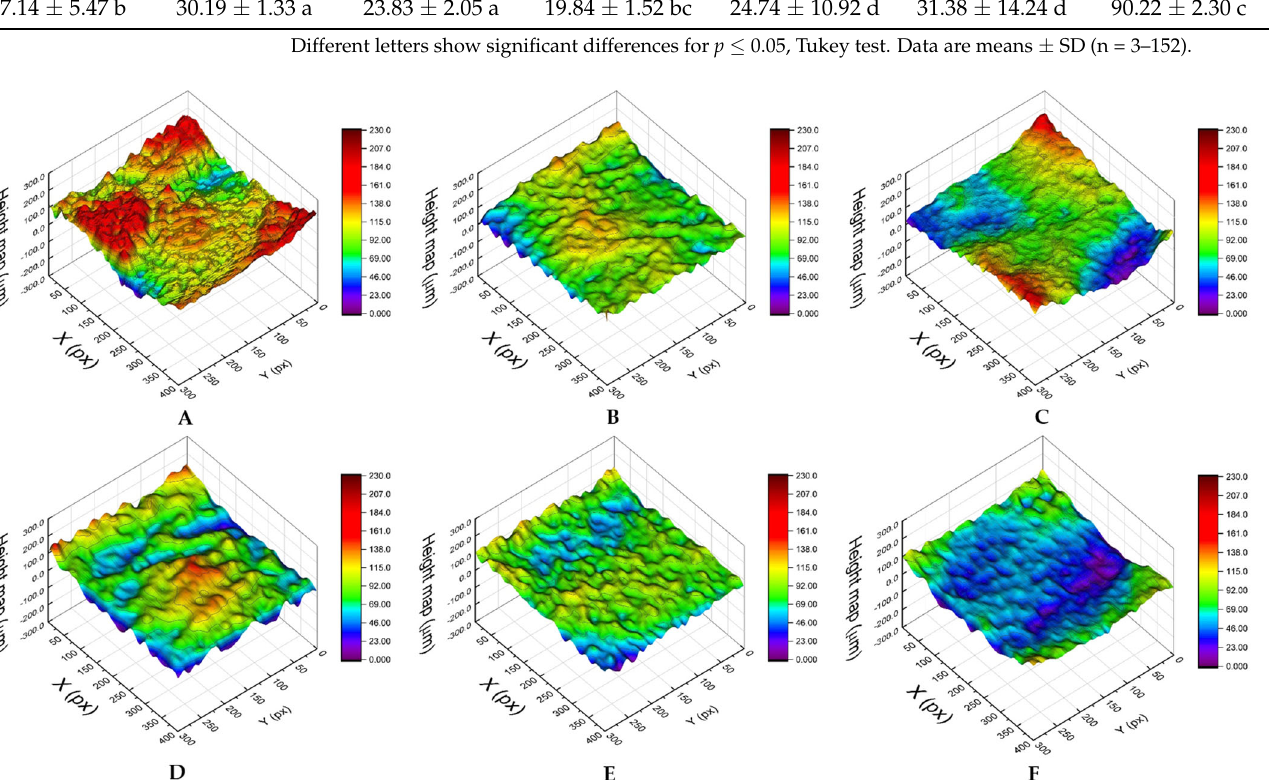
Figure 3. Examples of leaf surface 3D reconstructions of the six selected accessions: romaine lettuce ‘Bionda degli Ortolani’ ( A ), Swiss chard ( B ), rocket ( C ), wild rocket ‘Yeti’ ( D ), wild lettuce ( E ) and lamb’s lettuce ‘Trophy F1 ′ ( F ). X and Y axes are expressed in pixels (1 pixel = 17.5 μ m), with heights reported on the vertical axis ( μ m). The corresponding color ramp is shown on the right of each reconstruction.